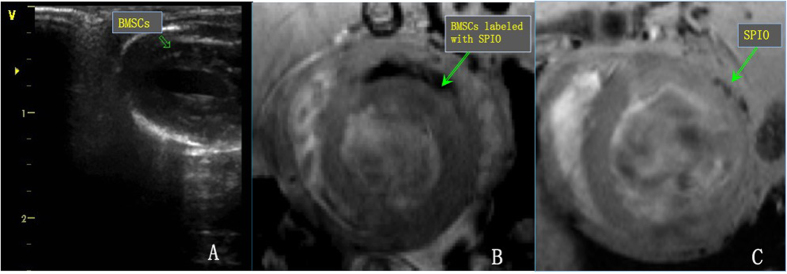
Bone mesenchymal stem cell (BMSC) tracking in vivo.(A) On transthoracic echocardiography, BMSCs at the border of the infarcted myocardium appeared as hyper-echoic lesions. On the cardiac MR imaging, SPIO-labelled BMSCs were visible as a hypo-intense area with sharp borders at the injection site after transplantation (B), but the SPIO signals became nearly undetectable after 14 days (C).